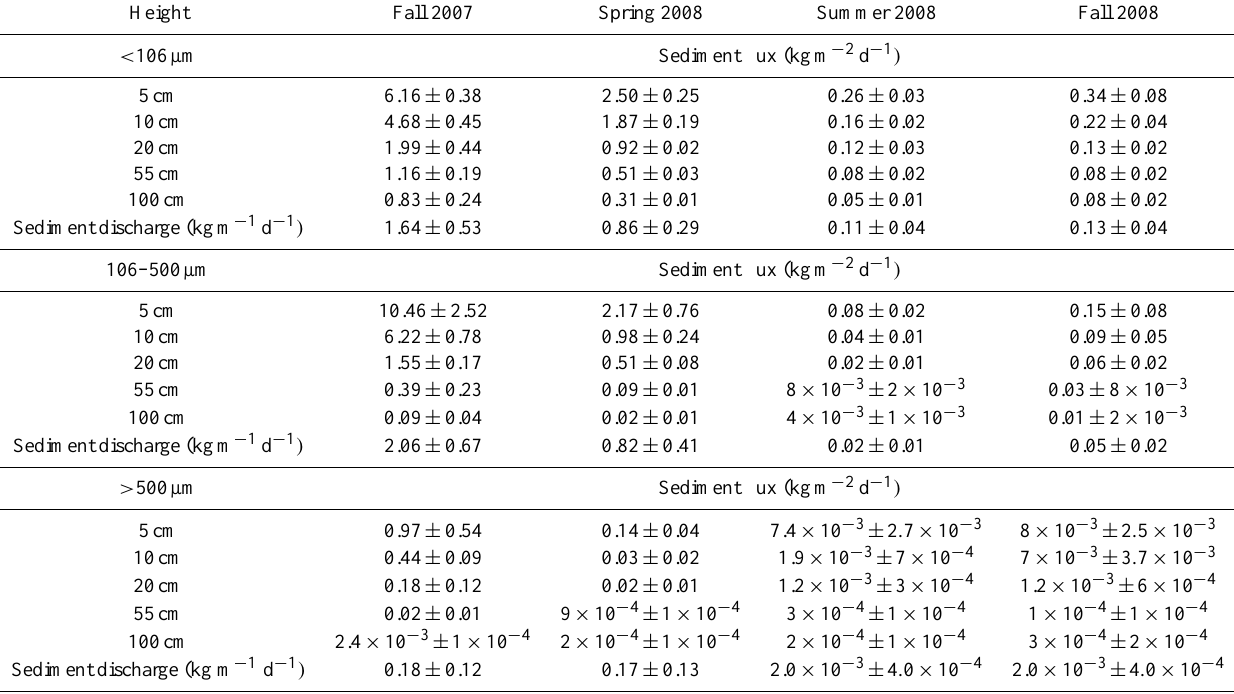
Table B1. Mean ( ± SE) sediment flux (kgm − 2 d − 1 ) and sediment discharge (kgm − 1 d − 1 ) for different size classes of sediment in the burned